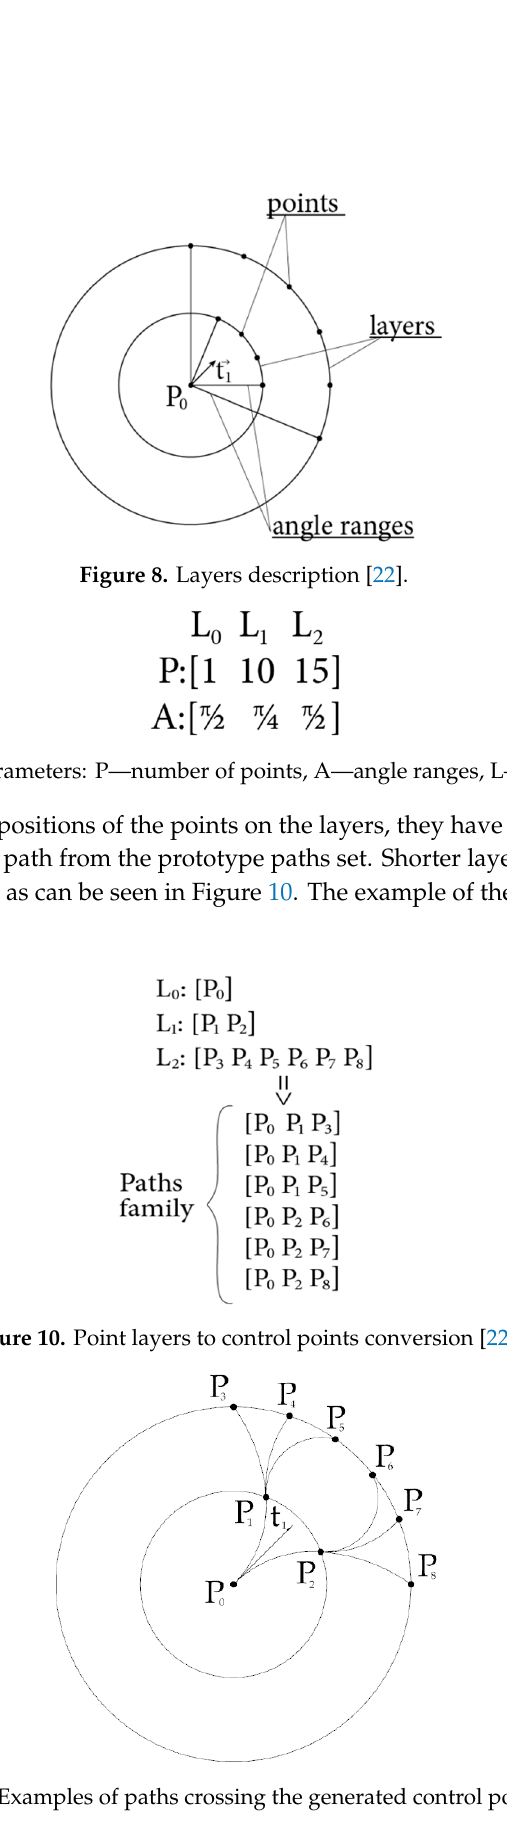
Figure 10. Point layers to control points conversion [22]. Figure 11. Examples of paths crossing the generated control points [22]. Figure 11. Examples of paths crossing the generated control points